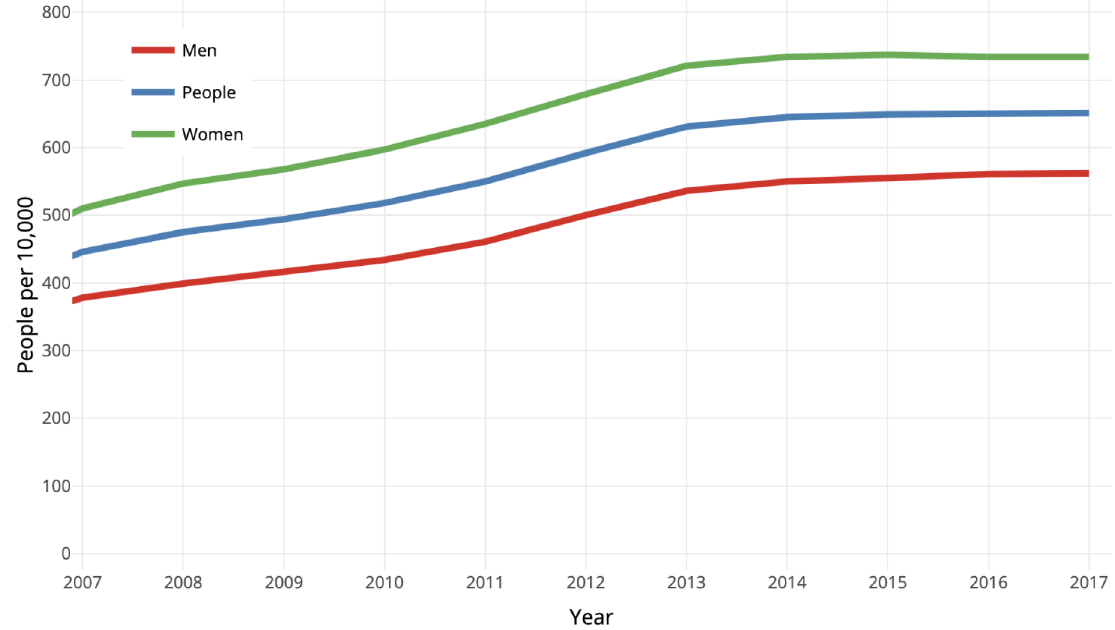
Figure 2: Prevalence of (age-standardised) prevalence of CKD by gender